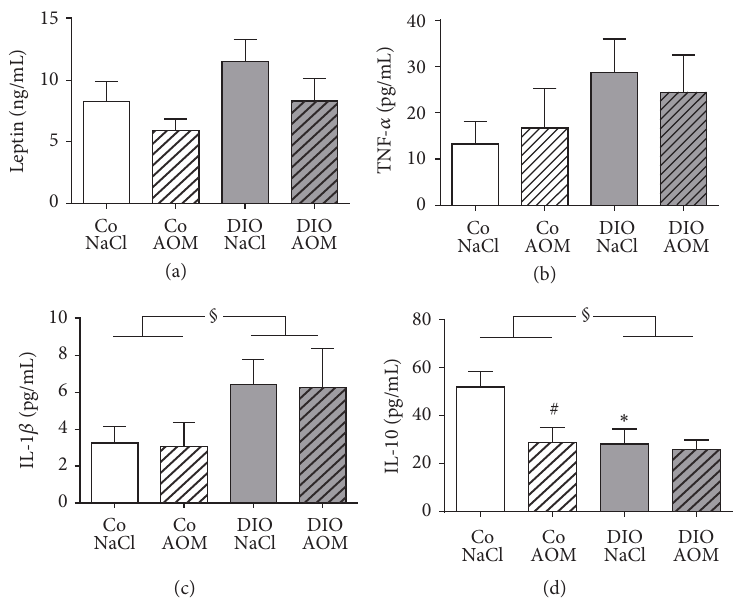
Figure 4: Plasma concentrations of leptin (a), TNF- 𝛼 (b), IL-1 𝛽 (c), and IL-10 (d) of normal weight [Co] and obese rats [DIO] treated with NaCl or azoxymethane (AOM). Data are expressed as mean ± SEM of 𝑛 = 11 –14 animals per group. # 𝑃 < 0.05 compared to NaCl-treated control group; ∗ 𝑃 < 0.05 , compared to appropriate control group. § 𝑃 < 0.05 , two-way-ANOVA, normal weight control groups compared to DIO